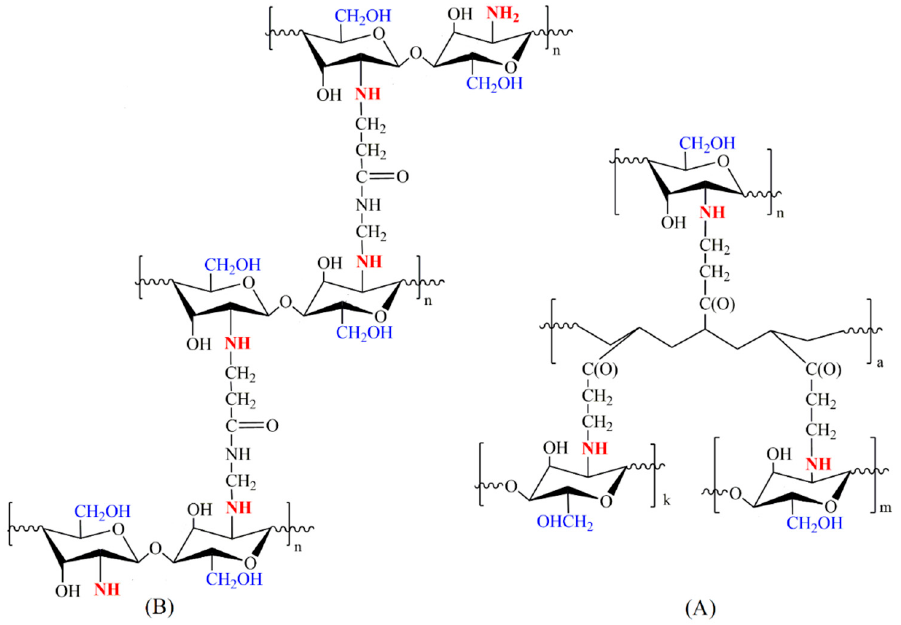
Figure 7. Proposed crosslinked structures of chitosan-g- N -methylolacrylamide obtained under different conditions (( A )—concentration, ( B )—UV irradiation).